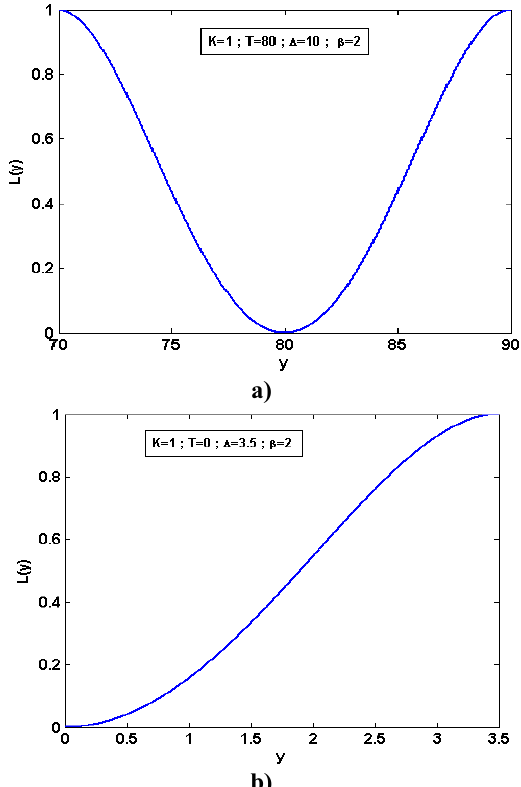
Figure 10. Loss functions for Example 1: a) bilateral LF, b) unilateral LF